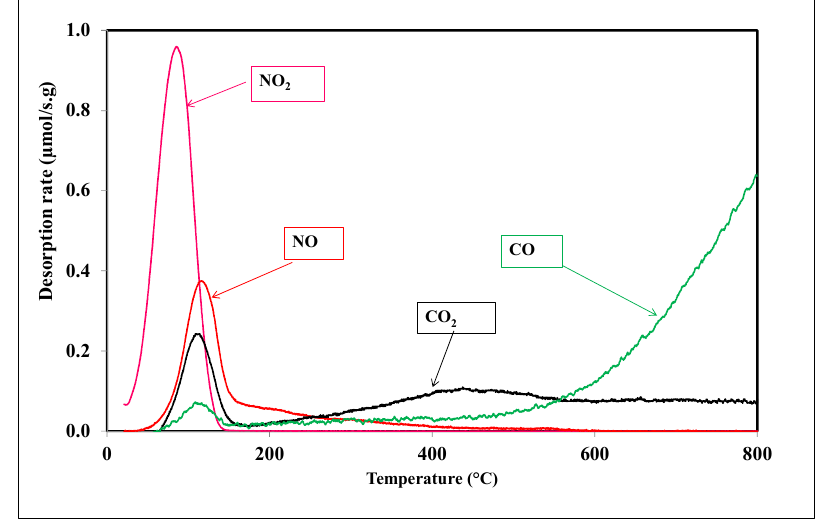
Figure 10. Emission of NO 2 , NO, CO, and CO 2 observed during the TPD experiment carried out under nitrogen flow after saturation of the activated carbon A surface by NO 2 .